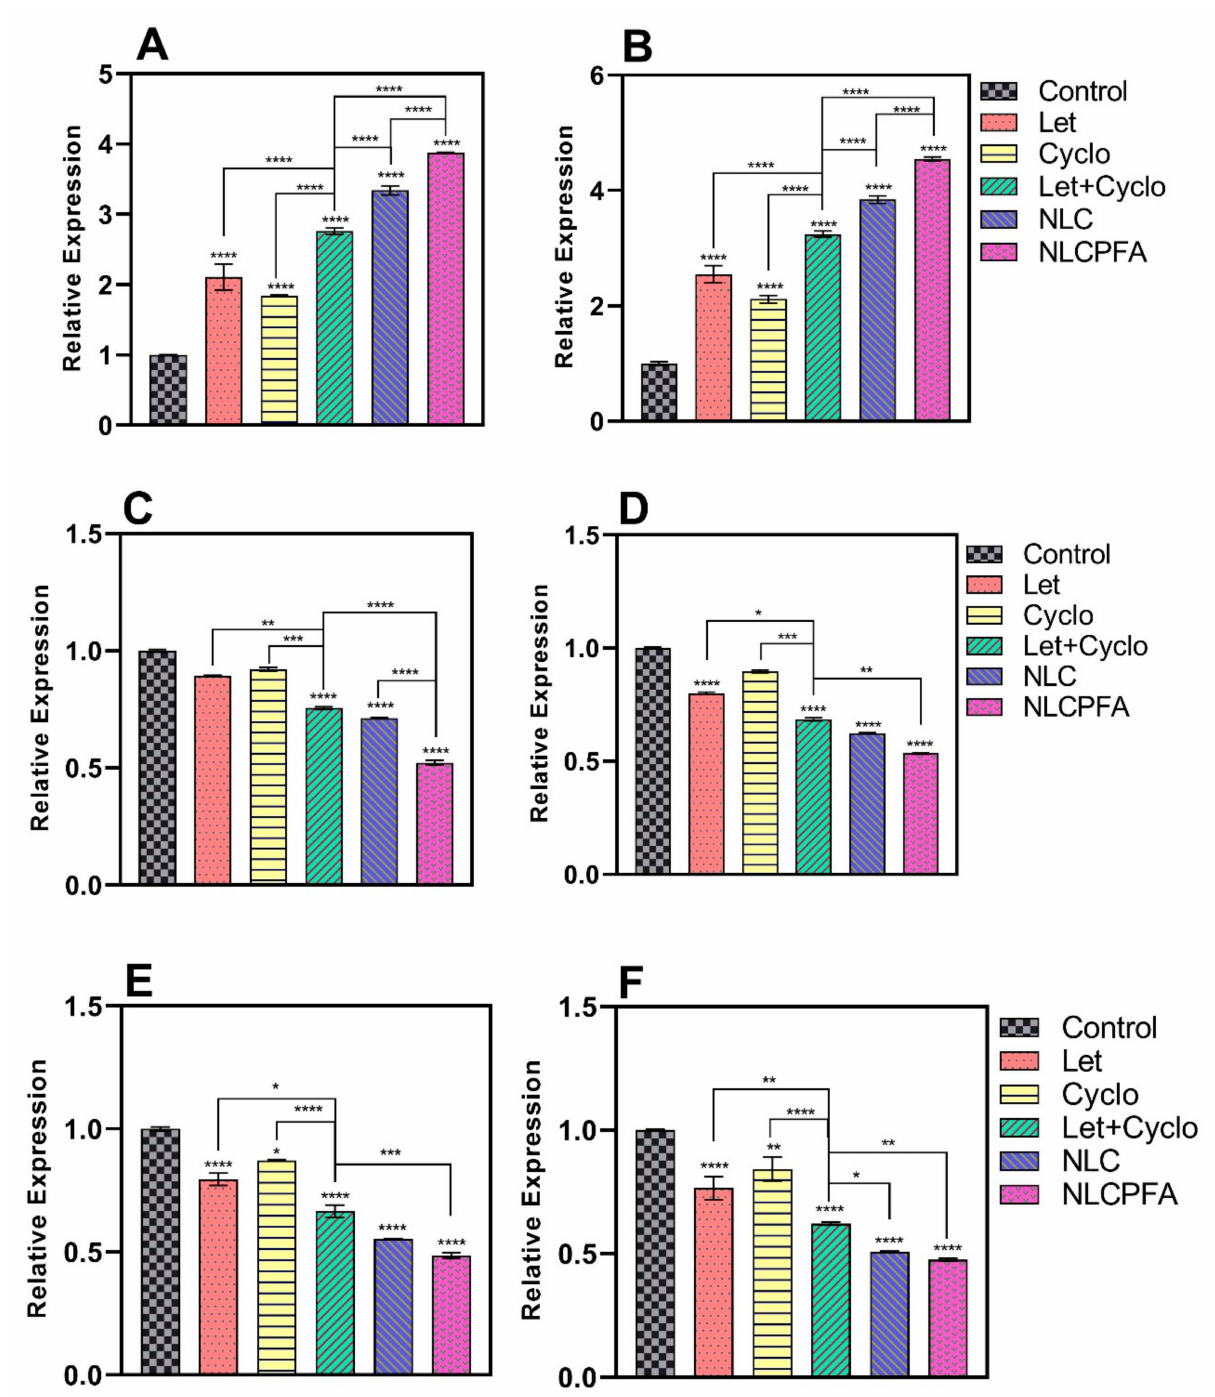
Figure 5. The expression level changes of ( A ) caspase-3 ; ( B ) caspase-9 ; ( C ) cyclin-D ; ( D ) cyclin-E ; ( E ) MMP-2 ; ( F ) MMP-9 genes in SKBR3 cancerous cell line after 72 h treatment by co-loading Let and Cyclo in different niosomal formulations at their IC 50 concentration (* p < 0.05, ** p < 0.01, *** p < 0.001, and **** p <